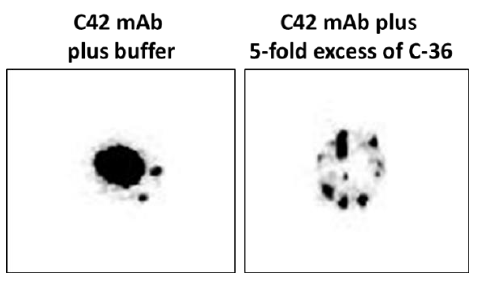
Figure 9. The C42 mAb pre-incubated with about five times excess of the C-36 peptide loses ability to react with C-36 in dot-blot analyses. We applied C-36 peptide (1 µ g) into the nitrocellulose membrane. The dot-blotted membranes we probed with C42 mAb alone or with C42 mAb pre-incubated with C-36 peptide (1:800). The immune complexes were visualized with appropriate horseradish peroxidase-conjugated secondary antibodies (1:10,000) and enhanced by ECL blotting substrate. Images created with Chemidoc Touch imaging system. The representative image shows that C42 mAb well recognizes the C-36 peptide, whereas the pre-incubation of the antibodies with C-36 peptide for 1 h, eliminates this reactivity.